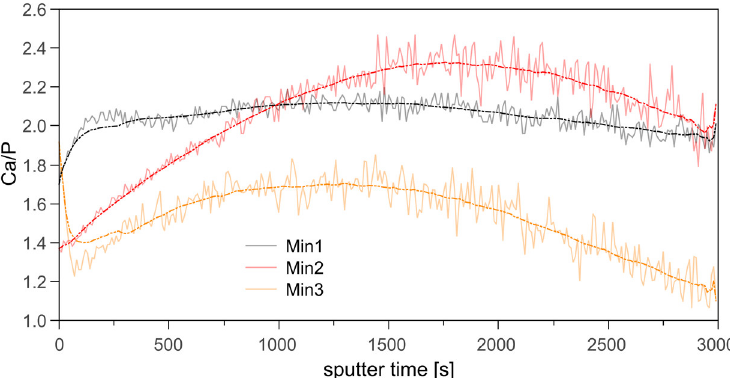
Figure 5. Ca/P ratios of Min1, Min2, and Min3 vs. sputter time calculated from the respective XPS sputter depth profiles in Figure 4: solid lines represent the experimental data; dash-and-dot lines are the respective sliding averages from the experimental data.